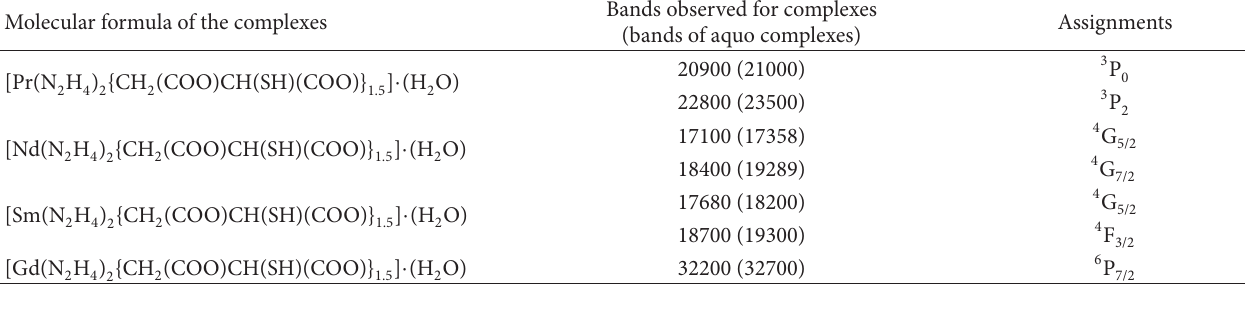
T 3: Energies (in cm